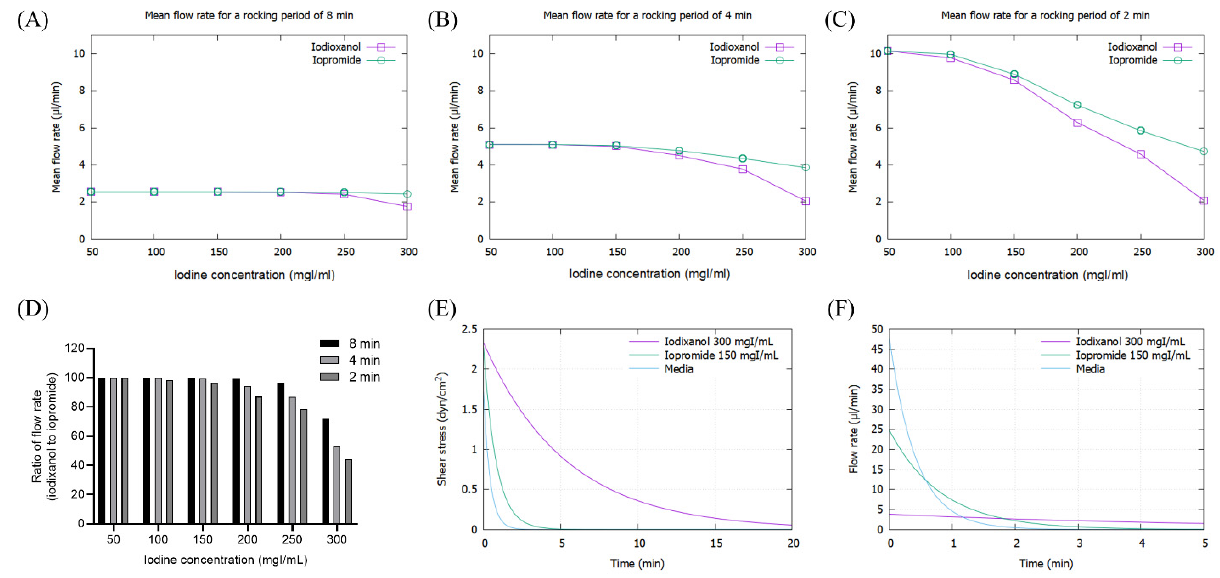
Figure 3. Mathematical simulation of fluid flow rates and shear stresses of iopromide and iodixanol. ( A ) Mean flow rate with a rocker interval of 8 min; ( B ) mean flow rate with a rocker interval of 4 min; ( C ) mean flow rate with a rocker interval of 2 min; ( D ) ratio of flow rate (iodixanol to iopromide); ( E ) fluid shear-stress during a single cycle of rocking. The concentrations of iodixanol and iopromide were selected on the assumption that IOCM is approximately two times more concentrated than LOCM through the renal tubule. ( F ) Fluid flow rate during a single cycle of rocking.